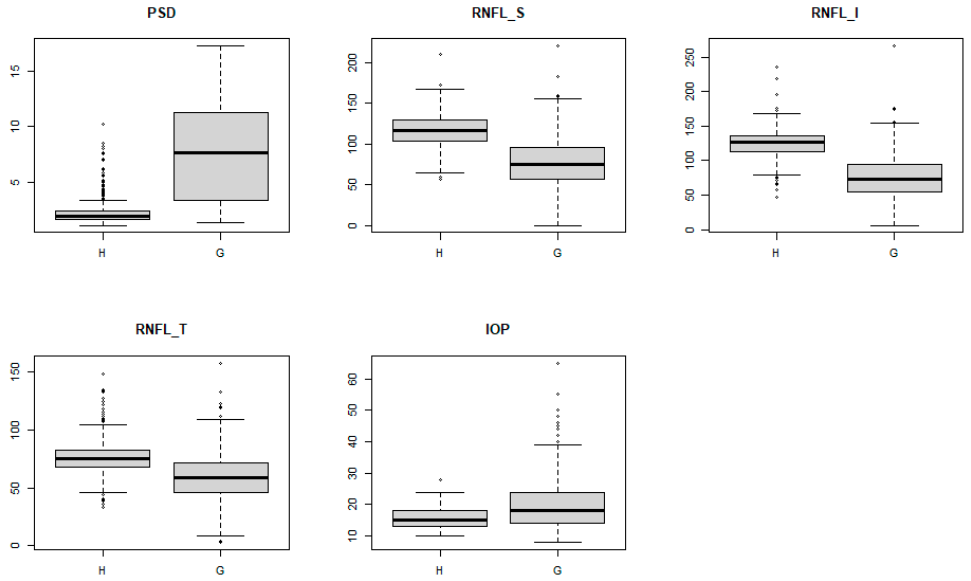
Figure 2. Box plots for selected features (H, healthy control; G, glaucoma).